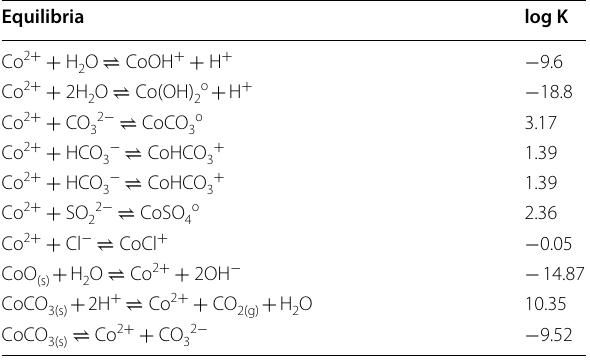
Table 1 Homogeneous and heterogeneous equilibria of inorganic Co 2 + in aqueous medium Equilibria log